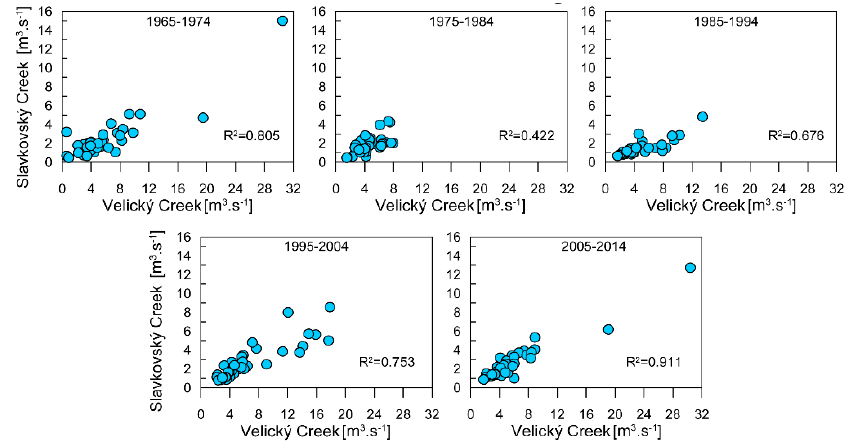
Figure 11. Relationships between peakflow discharges (four greatest runoff events in each year) in the VP (horizontal axis) and SP (vertical axis) catchments in the decades from 1965–1974 to 2005–2014 .